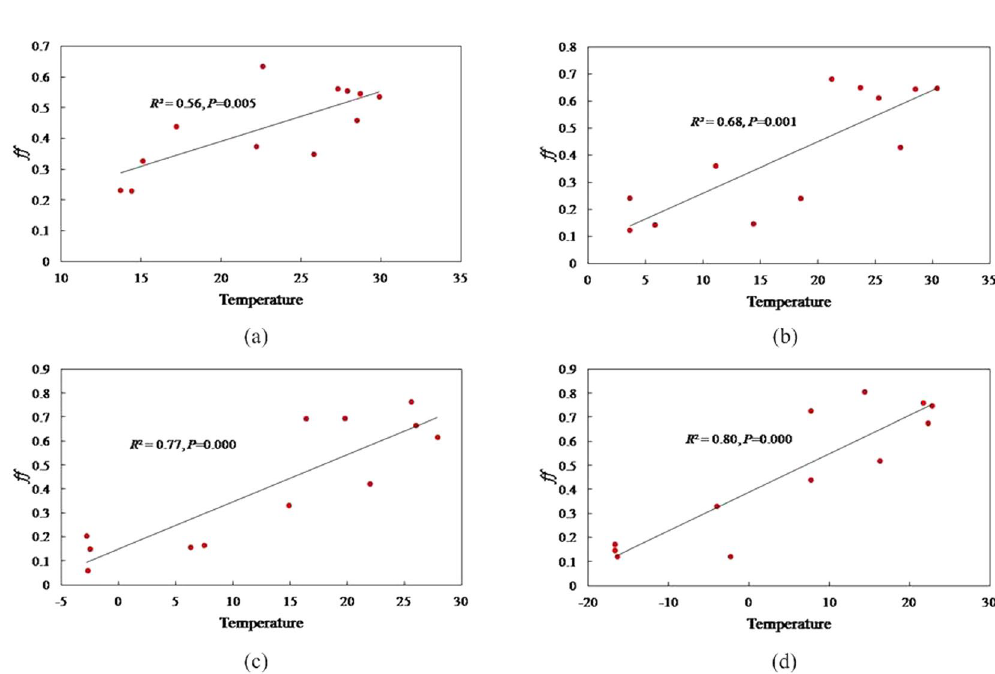
Figure 5. The relationships between the temperature and fugacity fraction (ff) for PCB28 in the latitudinal direction from south to north around four cities, ( a ) Guangzhou, ( b ) Wuhan, ( c ) Beijing, and ( d )